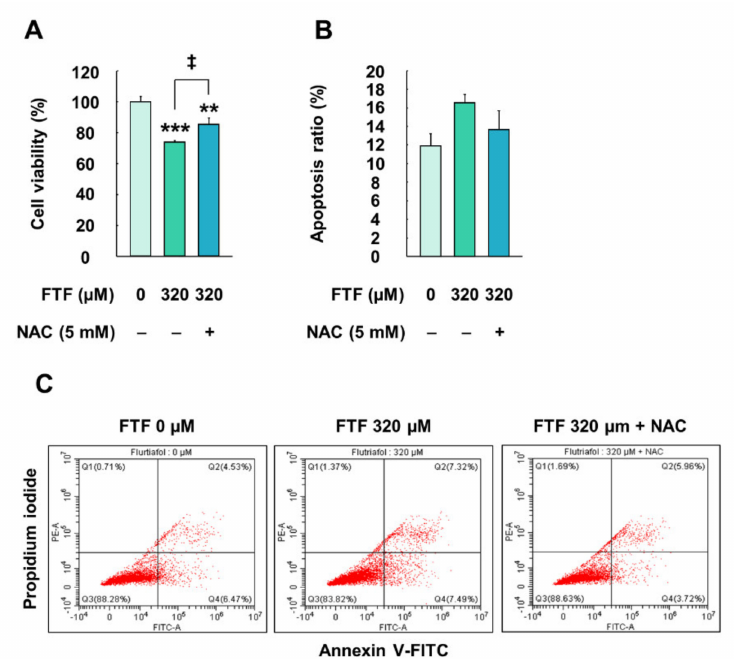
Figure 5. Effects of FTF on cell viability and apoptosis in HepG2 cells: ( A ) cell viability in HepG2 cells; ( B ) quantification of the apoptotic cell ratio (early and late apoptosis) and ( C ) the percentages of necrotic (Q1), late apoptotic (Q2), viable (Q3), and early apoptotic (Q4) in HepG2 cells. The cells were treated with 320 µ M FTF for 24 h with 5 mM NAC pretreatment for 1 h ( n = 3 wells per group). Images are representative of three independent experiments. The results are expressed as mean ± SEM, and statistically significant differences, compared with the control (DMSO), are indicated as ** P < 0.05 and *** P < 0.001. ‡ P < 0.05 indicates a significant difference, compared to the 320 µ M FTF treatment group. Abbreviations: FTF, flutriafol; NAC, N-acetylcysteine; SEM, standard error of mean; DMSO, dimethyl